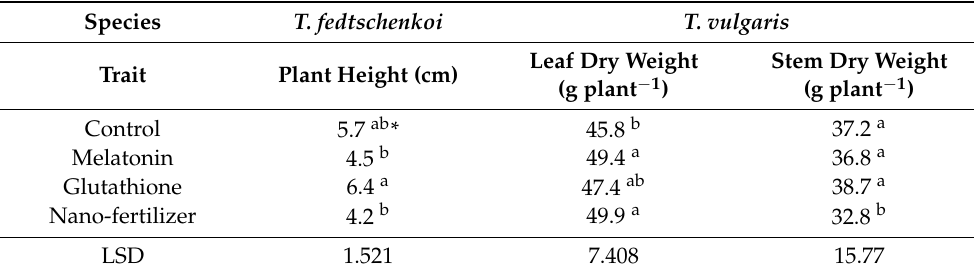
Table 1. Main effects of protectants compounds [water (control), melatonin, glutathione, iron-zinc nanofertilizer] on plant height of Thymus fedtschenkoi , and on leaf and stem dry weight of T. vulgaris . Within each column, different letters indicate significant differences.